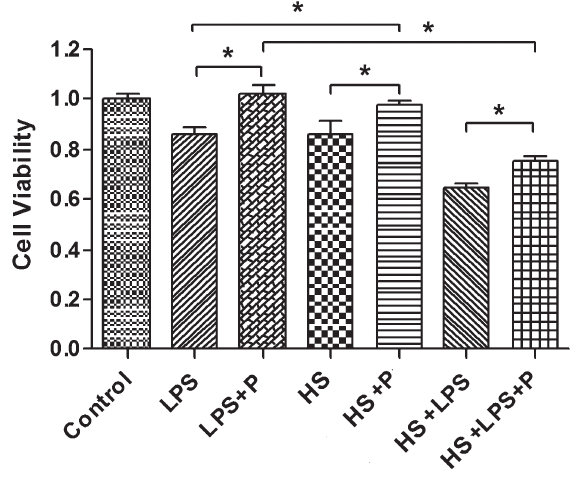
Figure 2. Effects of propofol (P) on the cell viability of IEC-6 cells after heat stress (HS), lipopolysaccharide (LPS), or a combina- tion of HS and LPS treatment. The MTT [3-(4,5-dimethylthiazol-2- yl)-2,5-diphenyltetrazolium bromide] method was used for eva- luation. Data are reported as means±SD, n=6. *P , 0.05, Student-Newman-Keuls test.